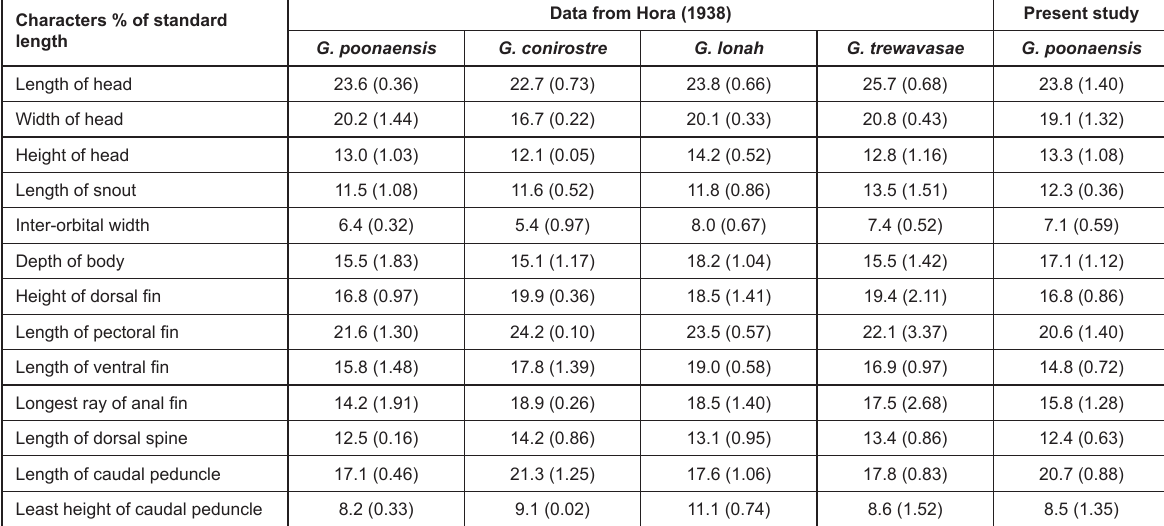
Table 3. Comparison among the morphometry of Glyptothorax given by Hora (1938) and present study. All characters are expressed as average of percentage of standard length with their standard deviations in the parenthesis. Characters % of standard